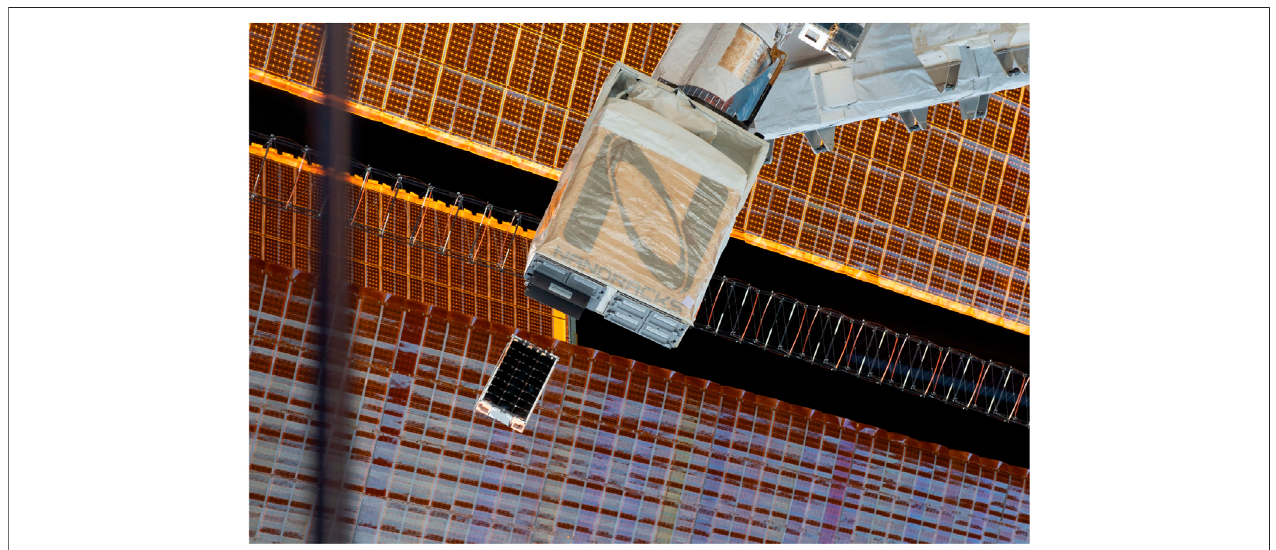
FIGURE 5 | DeMi CubeSat being deployed from the International Space Station. Image “ iss063e044976 ” from the ISS Cupola, courtesy